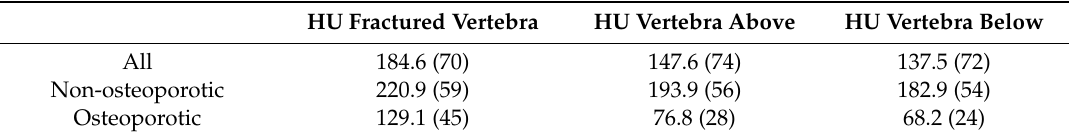
Table 3. Mean Hounsfield units (HU) measured in the fractured vertebra, as well as above and below (standard deviation). Measures for all patients and in both